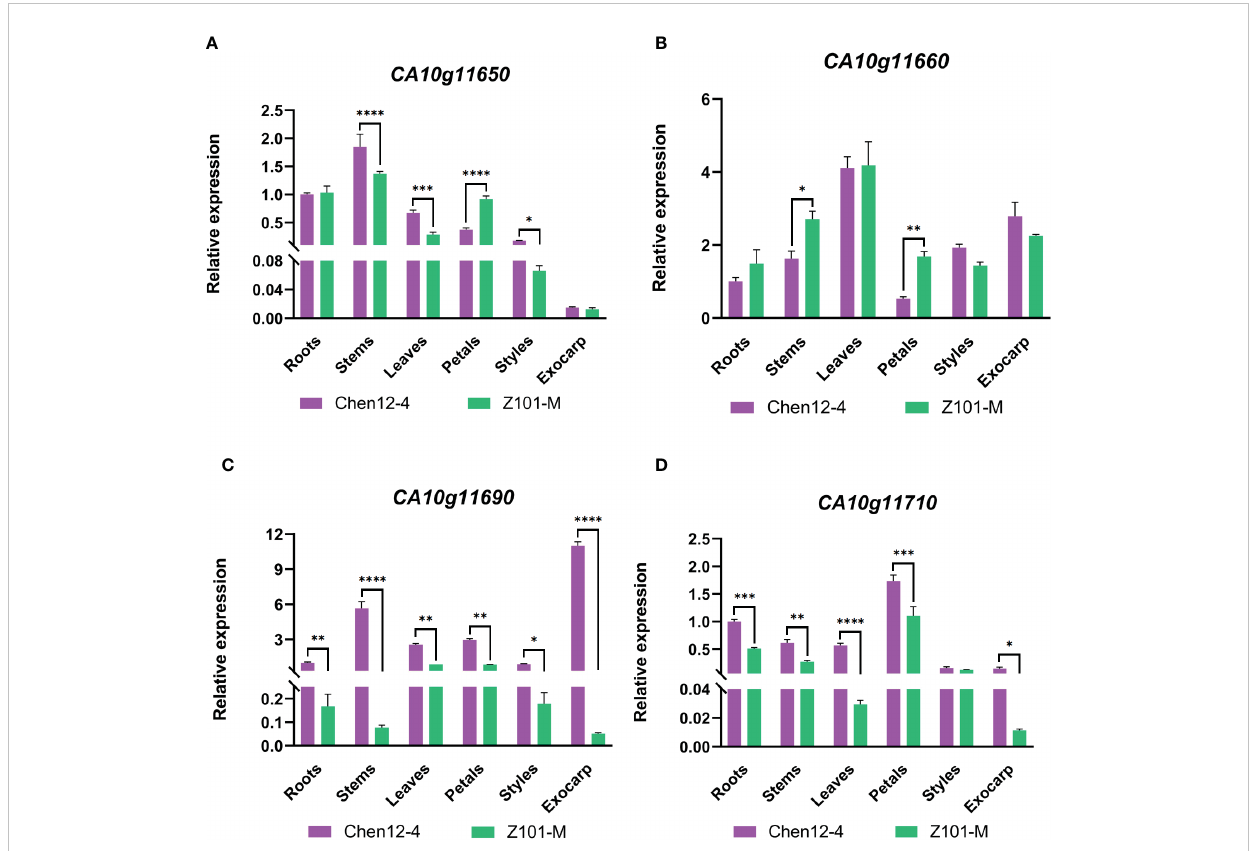
FIGURE 3 qRT-PCR analysis of the annotated candidate genes in stems, leaves, fl owers, mature unripe fruit, and ripe fruit of the two parental lines. (A) The patterns of expression of CA10g11650 in different tissues. (B) The patterns of expression of CA10g11660 in different tissues. (C) The patterns of expression of CA10g11690 in different tissues. (D) The patterns of expression of CA10g11710 in different tissues. The signi fi cant differences were identi fi ed using T-test, asterisks indicate a signi fi cant difference. ****P<0.0001, ***P<0.001, **P<0.01,